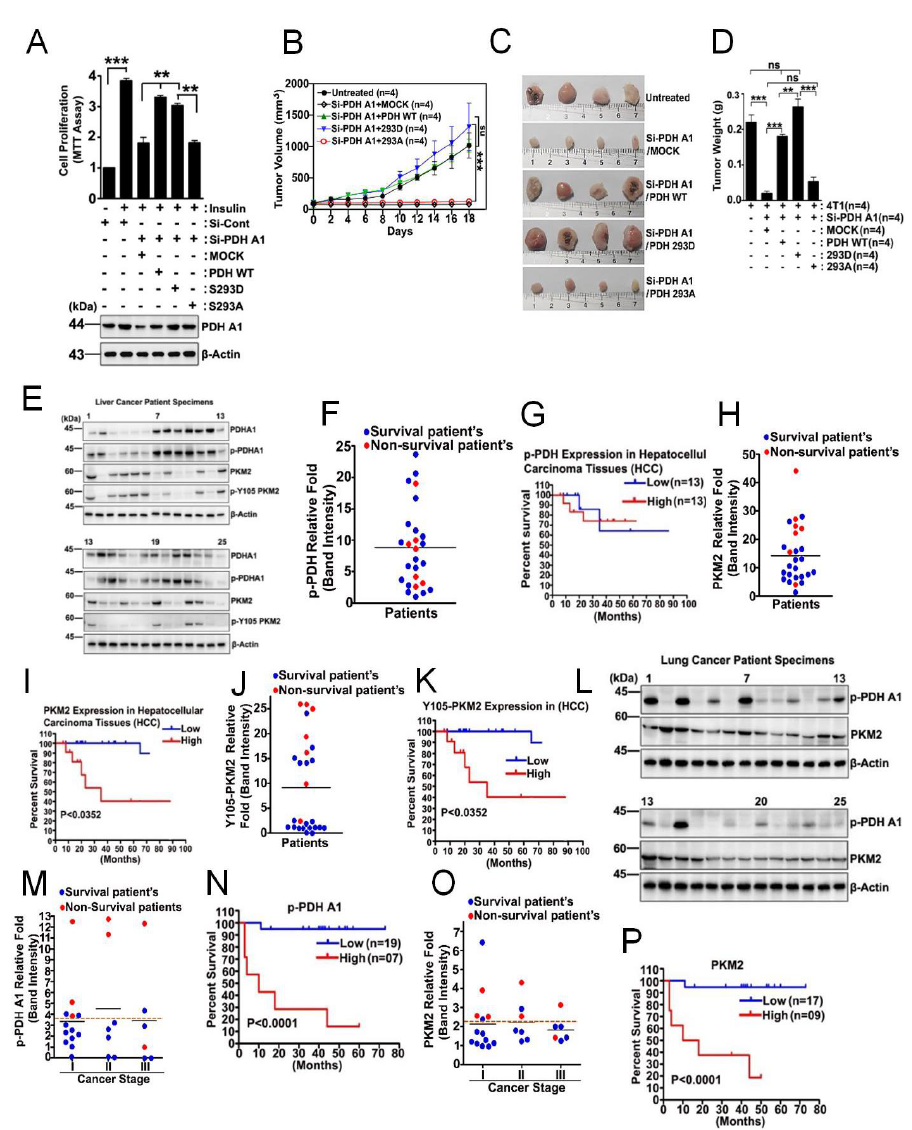
Figure 6. Increased p − PDHA1 levels correlate with poor survival probability. ( A ) 4T1 cells were treated with si-PDHA1, then addback with PDHA1 WT, S293D, or S293A, then activated with insu- lin (100 nM) for 48 h. Cell proliferation was assessed with an MTT assay, and the PDHA1 levels were determined by Western blotting. ( B , C ) Tumor volumes and tumor mass of 4T1 xenografts by using BALB/c mice containing si-PDHA1, plus the addback vector PDHA1 WT, S293D, or S293A mutants, were measured twice a week. ( D ) Tumor weight of 4T1 xenografts containing si-PDHA1